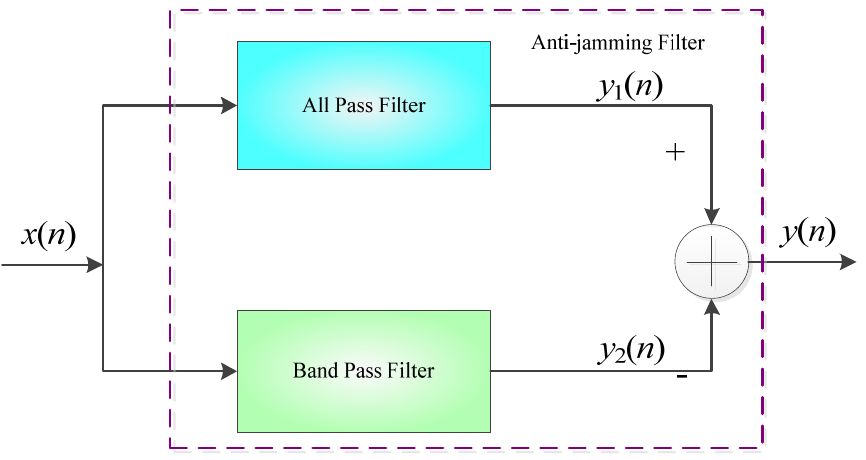
Figure 6. Schematic diagram of anti-jamming filter decomposition. For an all-pass filter, its discrete impulse response is δ ( n ) , and the time-domain discrete impulse response expression of an ideal band-pass filter is sin ω c n single-sideband bandwidth and ω 0 is the interference center